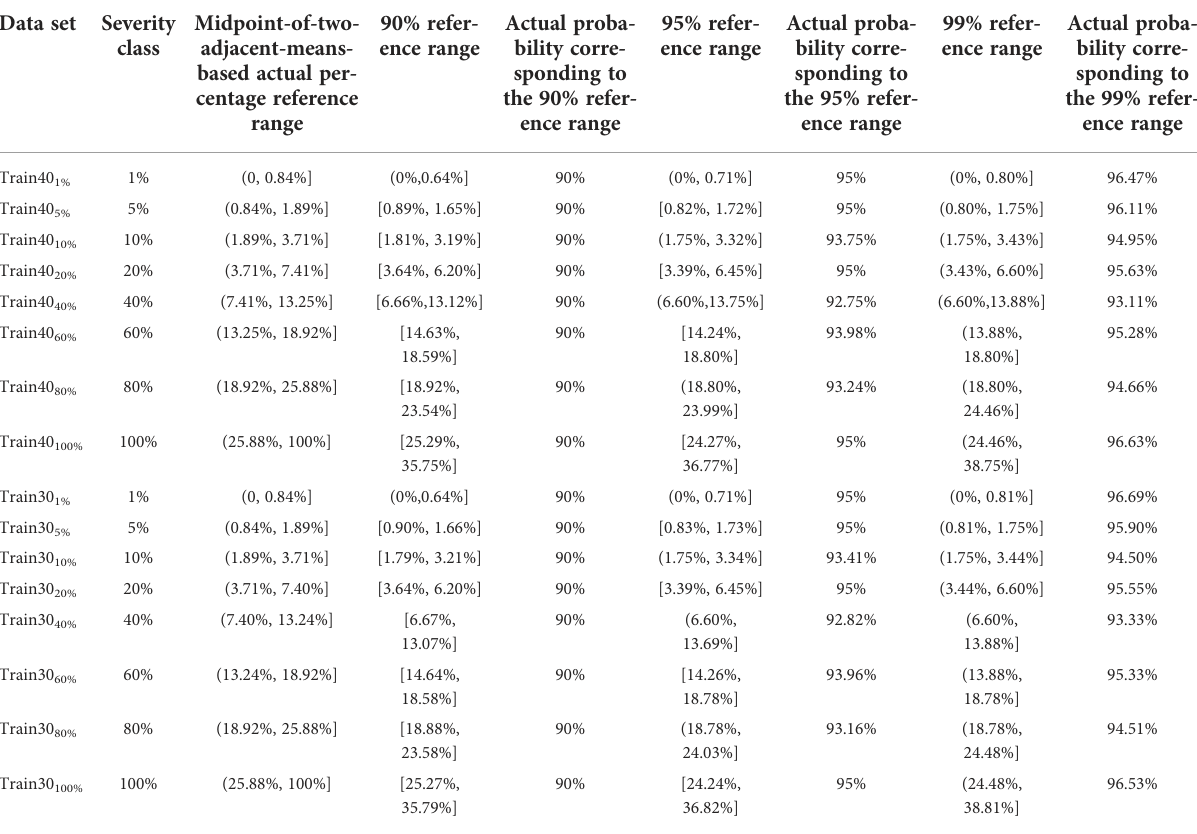
TABLE 3 The determined reference ranges of the actual percentages of lesion areas in the corresponding whole leaf areas for all the severity classes based on the actual percentage data in the training sets Train40 R and Train30 R and the actual probabilities for the corresponding 90%, 95%, and 99% reference